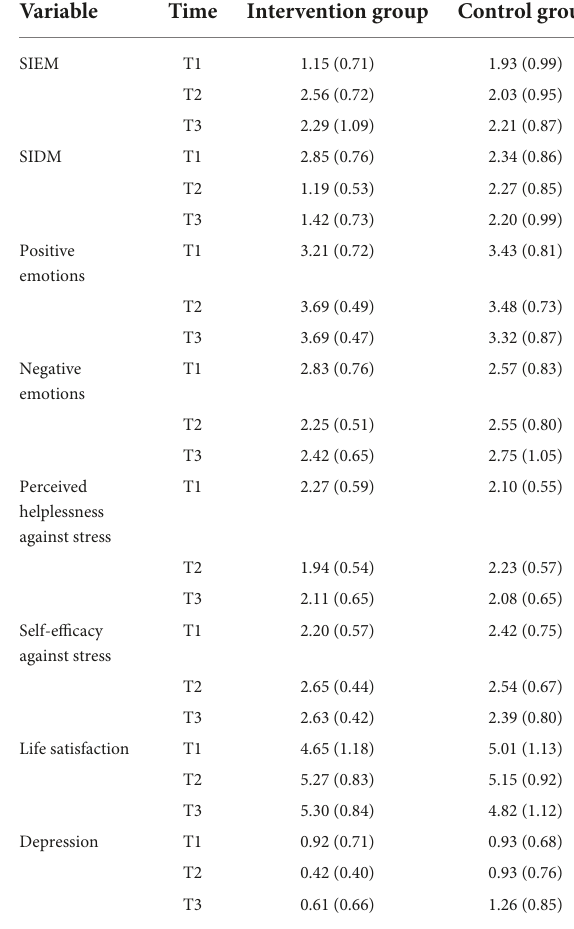
TABLE 4 Mean (standard deviation) of each variable as a function of time and condition ( N =